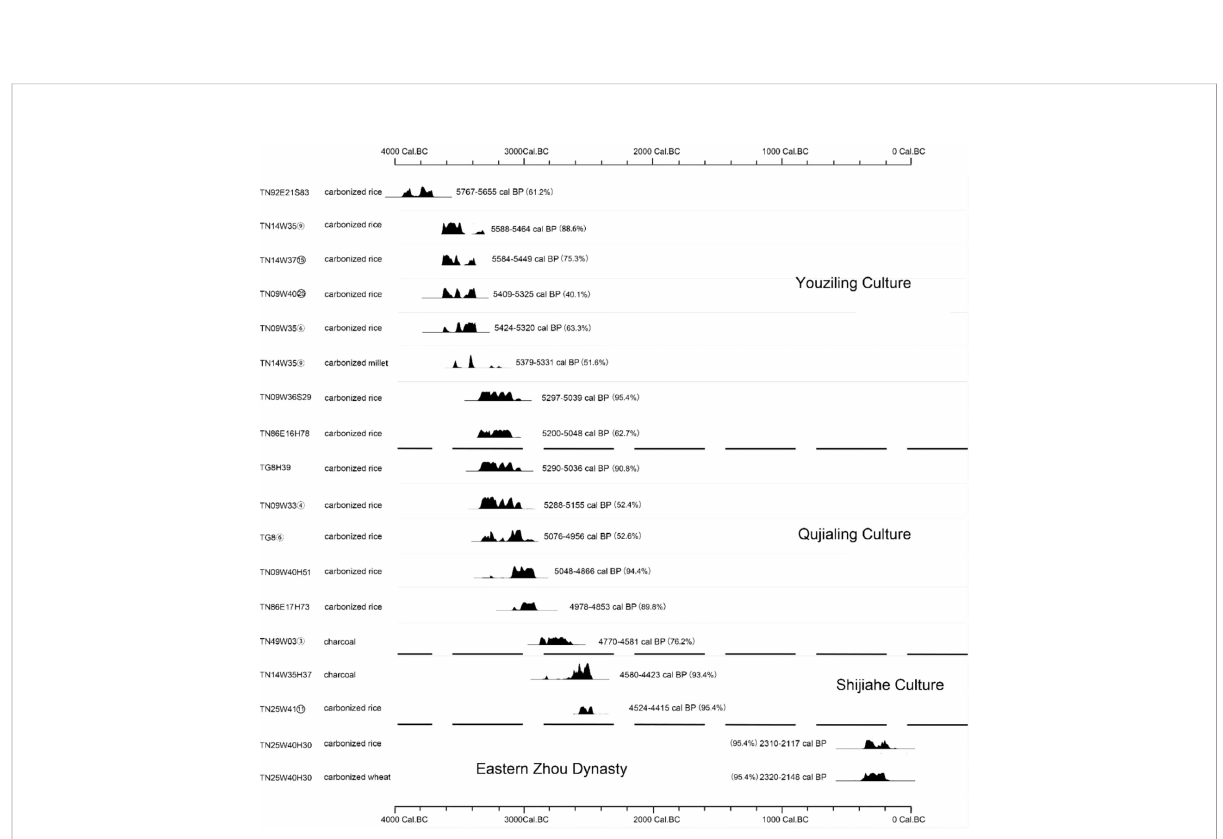
FIGURE 2 Carbon-14 dates and dendrochronologically corrected dates of charred macrofossil samples excavated at Qujialing (After Yao et al., 2019).